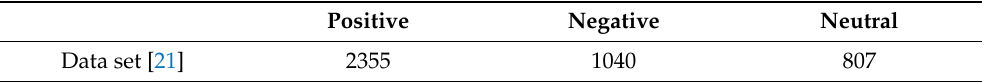
Table 2. Tweets per label in LASIK Surgery Data